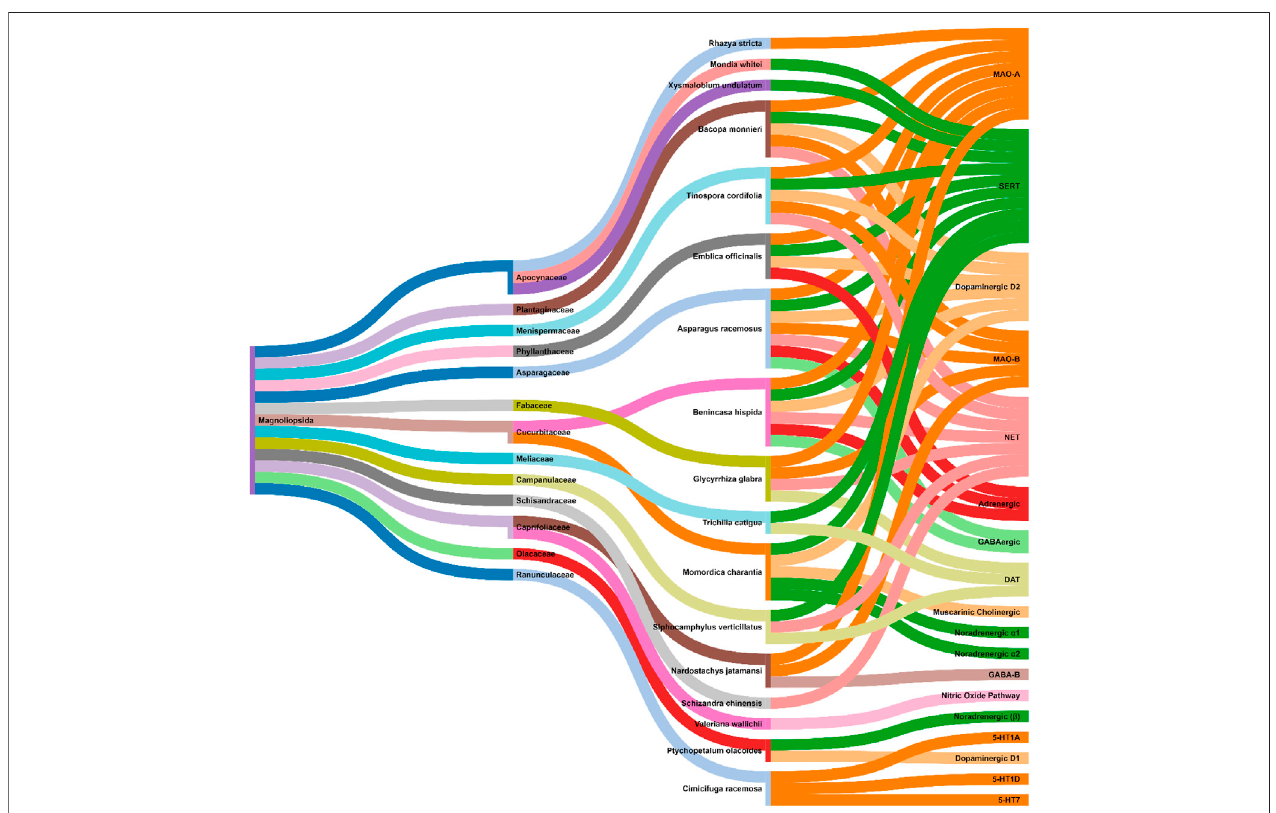
FIGURE3| Interactionanalysismaptoexpressassociationandrelationshipbetweenclassandfamilyofnaturalsourceswiththephysiologicalpathwaysrelatedto